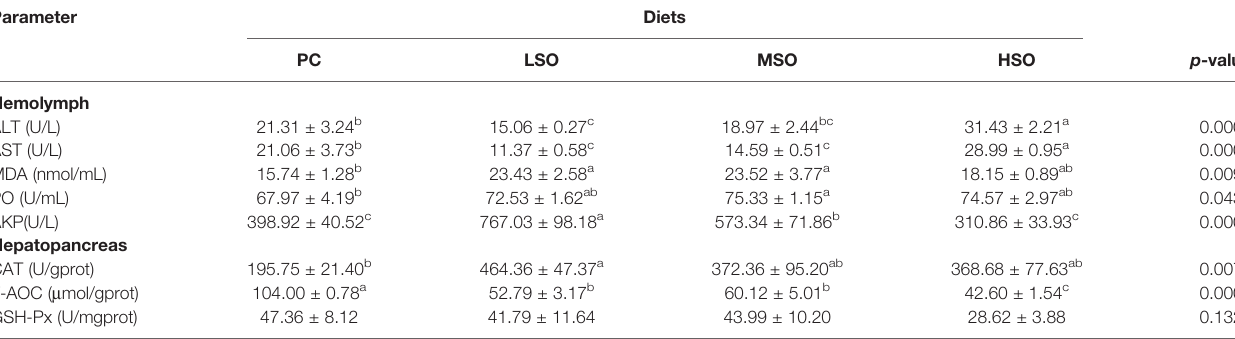
Data represent mean ± SD of three replicates (n = 3). Values with different superscripts in rows indicate signi fi cant difference (p < 0.05) based on Tukey ’ s multiple test. The lack of superscript letter indicates no signi fi cant differences among groups. ALT,alaninetransaminase;AST,aspartatetransaminase;MDA,malondialdehyde;PO,phenoloxidase;AKP,alkalinephosphatase;CAT,catalase;T-AOC,totalantioxidantcapacity;GSH- Px, glutathione